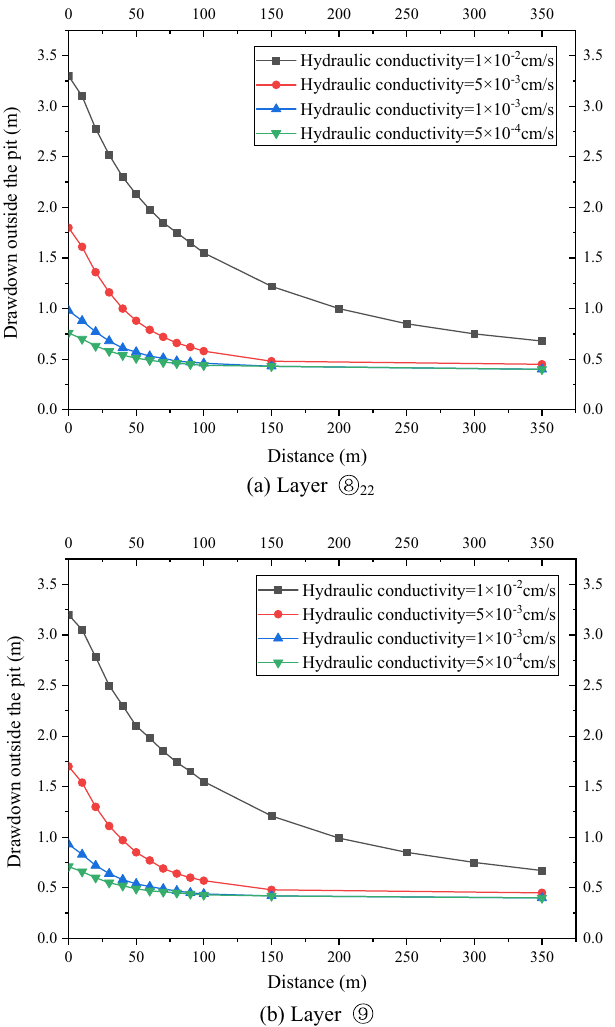
Figure 14. Drawdown–time curve outside the pit with different hydraulic